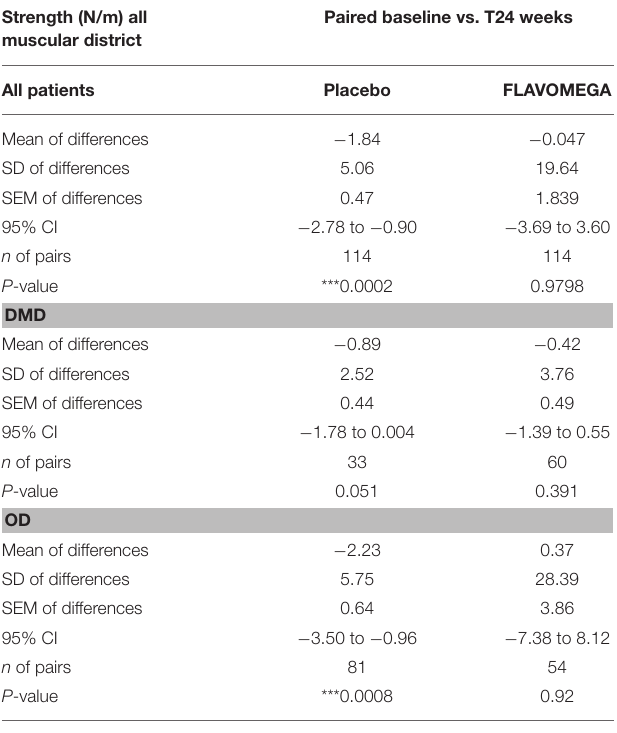
TABLE 9 | Biodex measurement of strength N/m (paired t -test) considering all muscular districts before and after treatment (baseline and T24wk) intra each